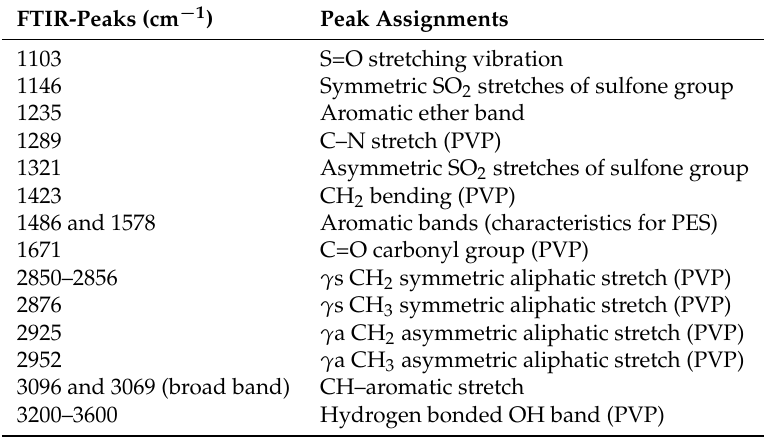
Table 2. Main functional groups in commercial membrane UH004 P